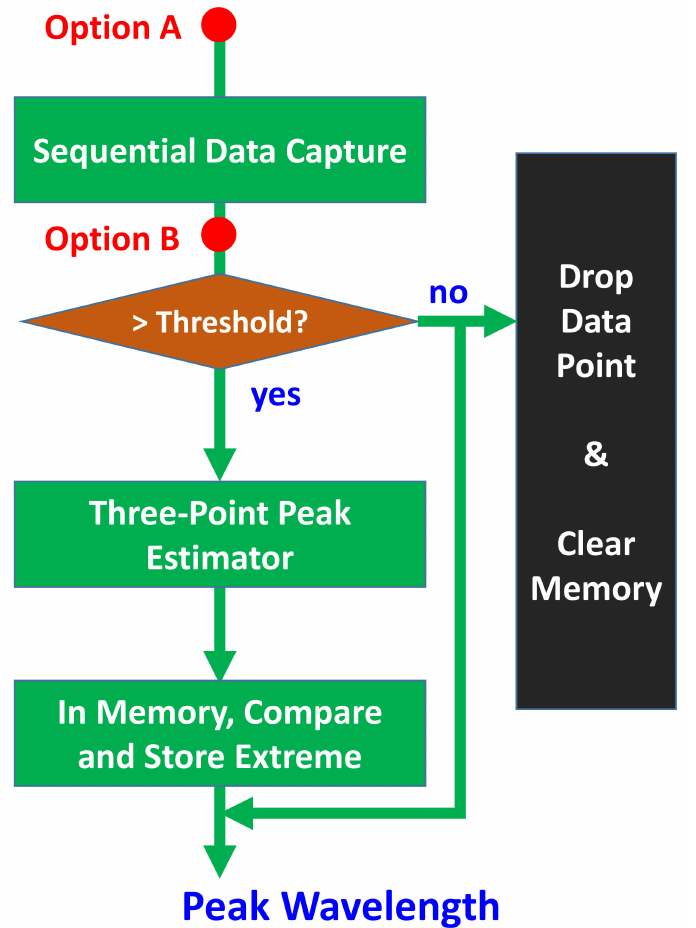
Figure 2. Processing flow of the proposed